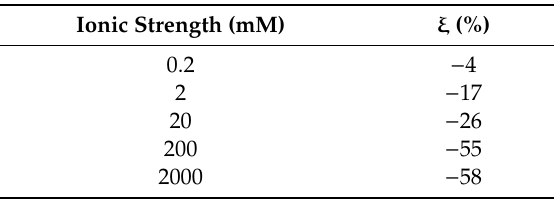
Table 1. Effect of the NaCl ionic strength on the global performance index of the biosorption of Ni 2+ by acorn shell of Quercus crassipes (QCS).